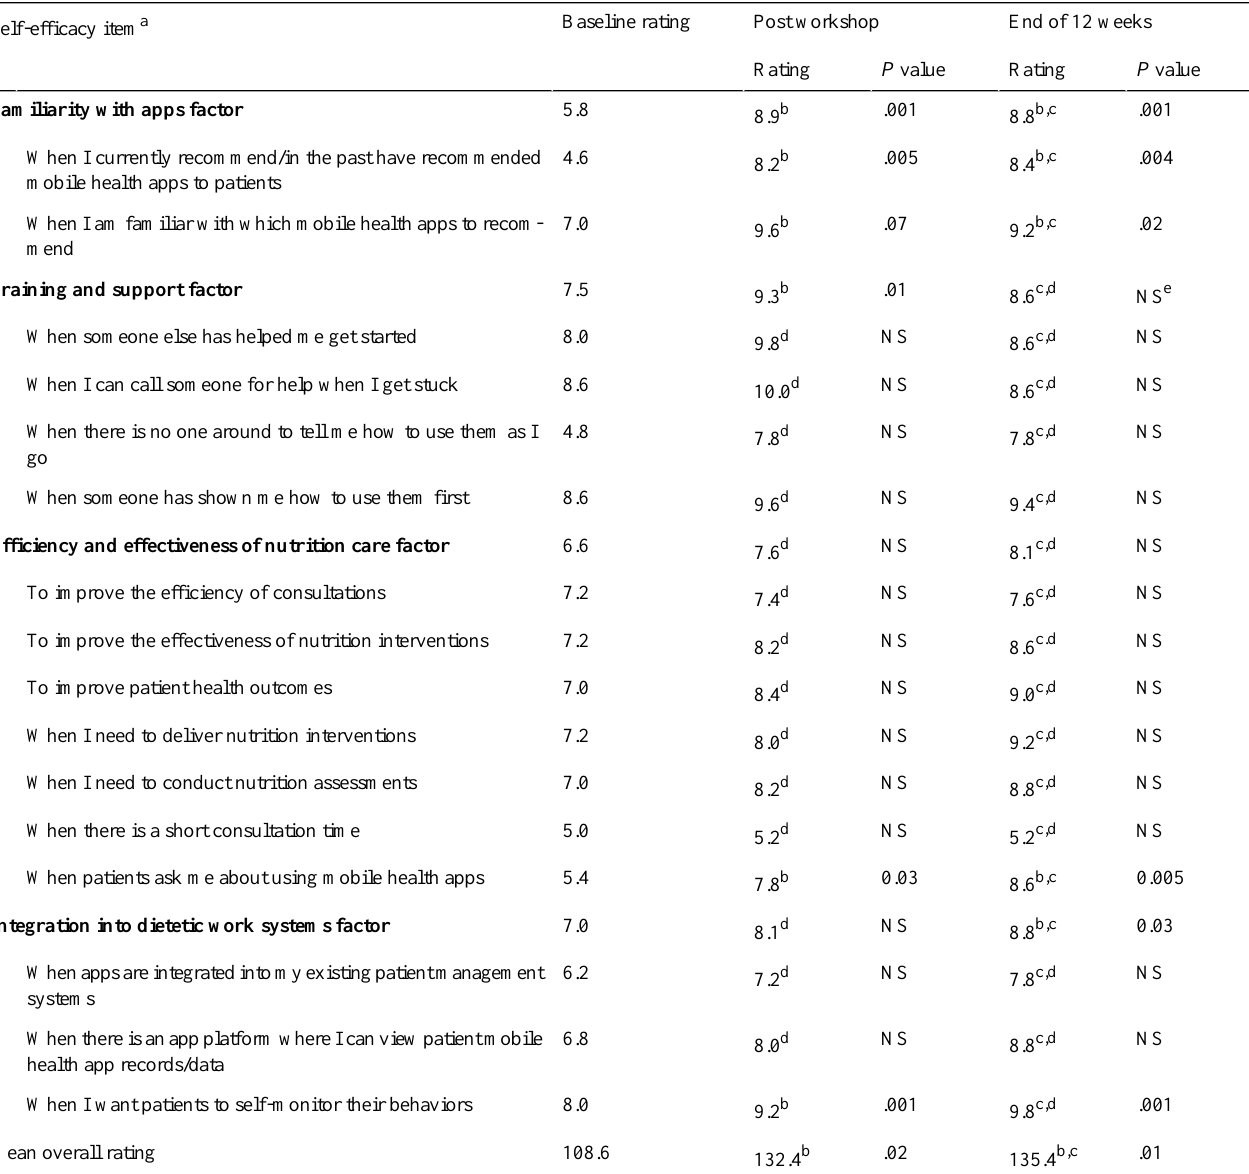
Table 3. Dietitians’ self-efficacy with mobile health apps before and after attending the educational and skills training workshop on apps as well as after 12-weeks of practical opportunities to use mobile health apps in their practice. The mean ratings for individual items and factors are presented. One-way analysis of variance was conducted followed by the Tukey post hoc